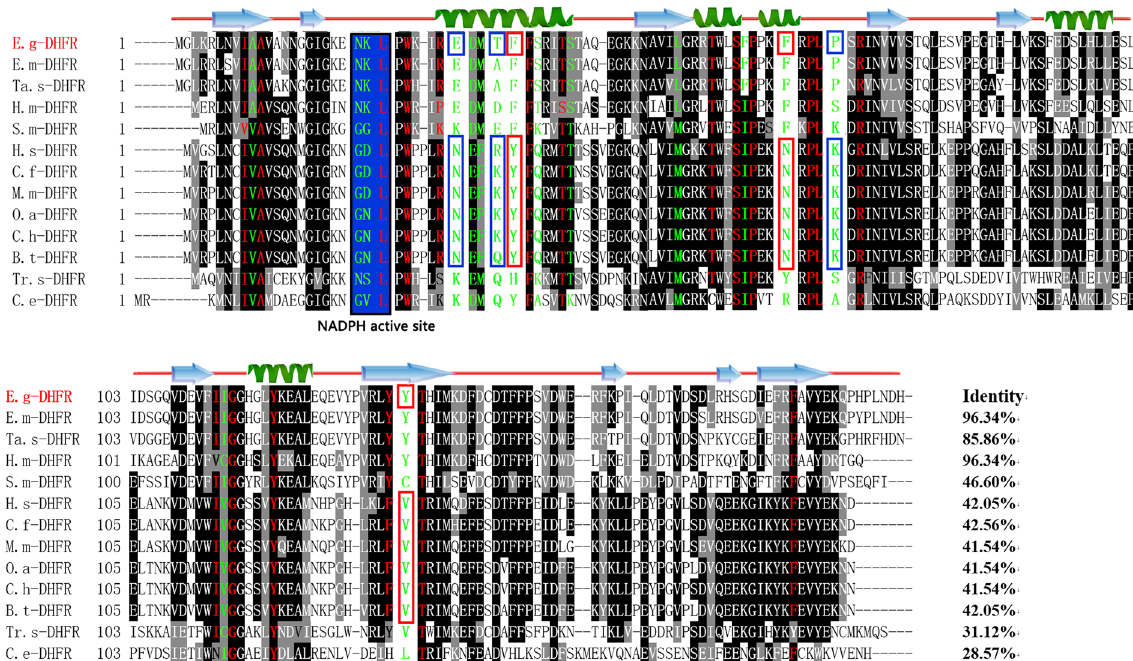
Figure 1. Sequence alignment analysis of E. granulosus DHFR. Alignment of the deduced amino acid sequence of Eg-DHFR (GeneDB: EgrG_000572400) with homologues from other species. The percentage homology of Eg-DHFR with each DHFR is shown at the end of the alignment. Different active-site residues between mammalian (host) and E. granulosus DHFRs are indicated by green letters, and identical active-site residues are indicated by red letters. Active-site residues with charge changes are marked with blue boxes (mammalian host - E. granulosus , Asn30 - Glu30, Asp/Asn22 - Lys22, Arg/Lys33 - Thr33, and Lys68 - Pro68). The exchange of polar and nonpolar residues (Tyr34 - Phe34, Asn64 - Phe64, Val136 - Tyr135) is marked with red boxes. The NADPH binding-site is highlighted with a blue background. The predicted secondary structure of Eg-DHFR is displayed above the alignment. Accession numbers: Echinococcus granulosus DHFR (E.g-DHFR) GeneDB: EgrG_000572400; Echinococcus multilocularis DHFR (E.m-DHFR) GenBank: CDS38333.1; Taenia